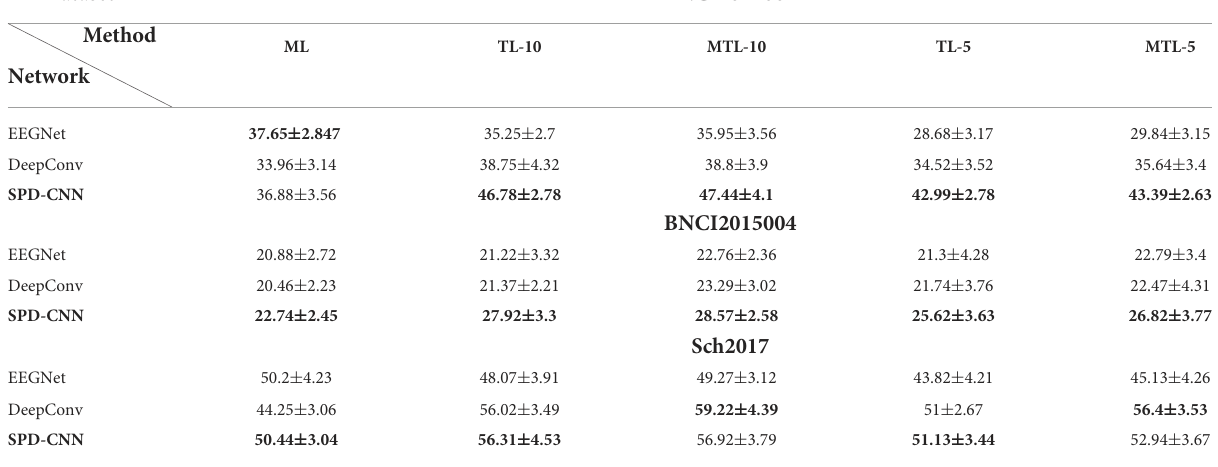
TABLE 4 The 4-way, 10-shot, and 5-shot classification accuracy ( % ) on three datasets (5-way for BNCI2015004).